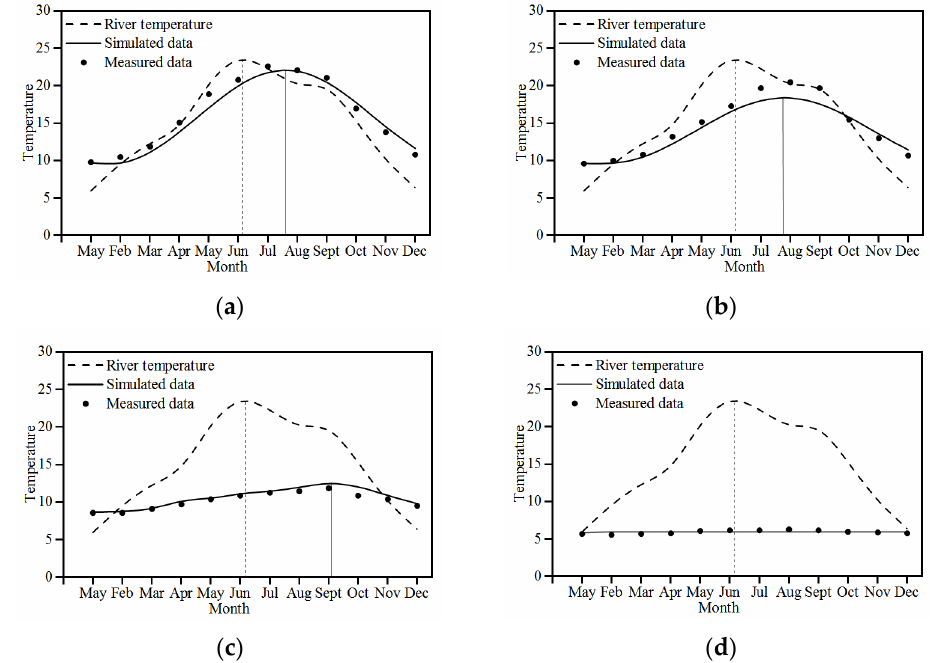
Figure 4. Temperature at different depths of Xulong. ( a ) Water depth 20 m. ( b ) Water depth 40 m. ( c ) Water depth 100 m. ( d ) Bottom of reservoir. ( c ) Water depth 100 m. ( d ) Bottom of